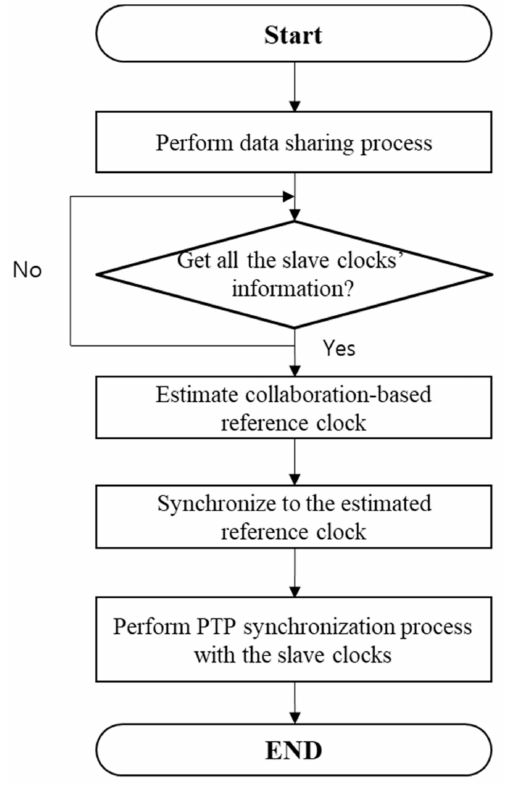
Figure 5. The flow chart of the proposed collaborative clock correction